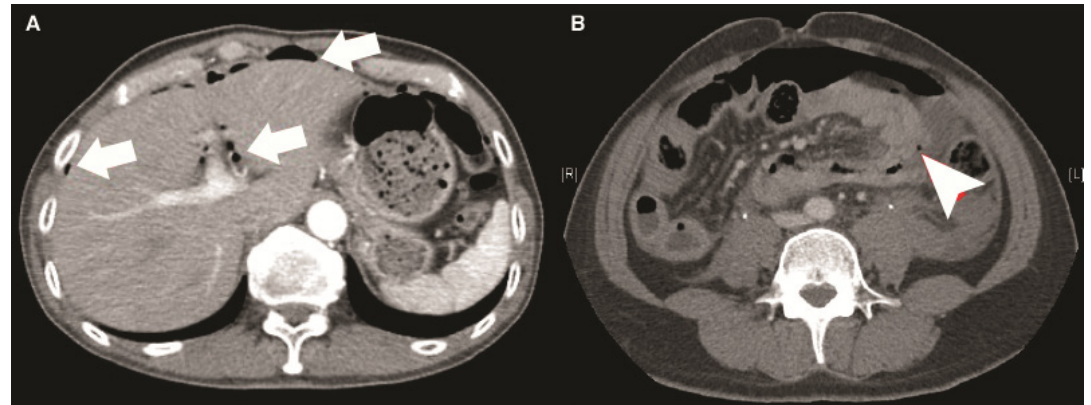
Figure 1. ( A ) The axial computed tomography presented multiple extraluminal air (arrows). ( B ) The abdominal computed tomography revealed a small extraluminal air bubble with focal fluid (arrowhead).